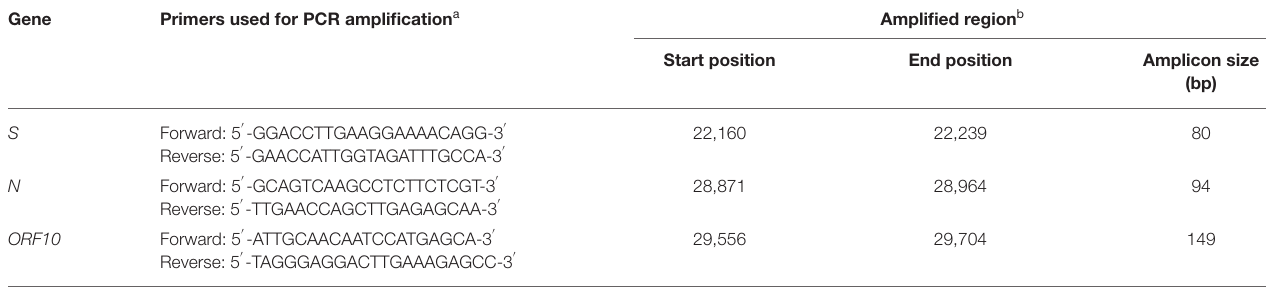
TABLE 1 | Fragments of viral genes that were PCR-amplified and sequenced here. Gene Primers used for PCR amplification